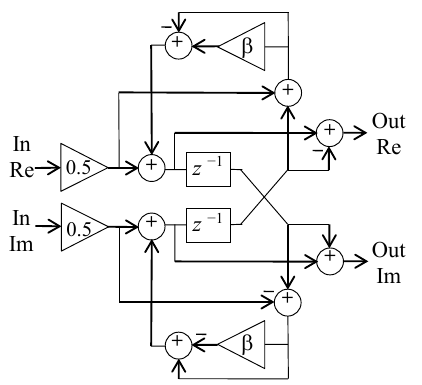
Fig. 5. Bilinear orthogonal complex LS 11-based filter [25].